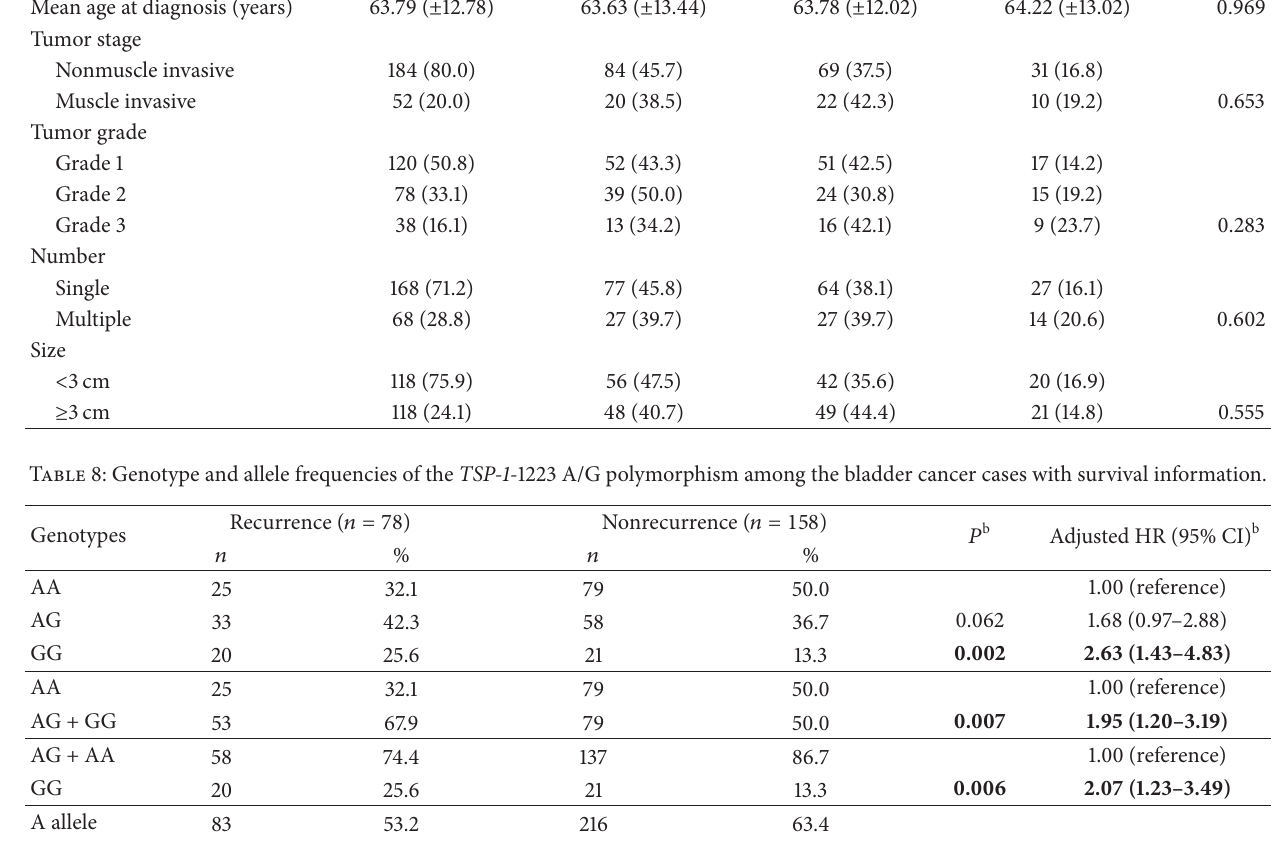
Table 7: Demographic and clinical characteristics at primary diagnosis and genotype distribution in patients with bladder cancer. Genotypes All